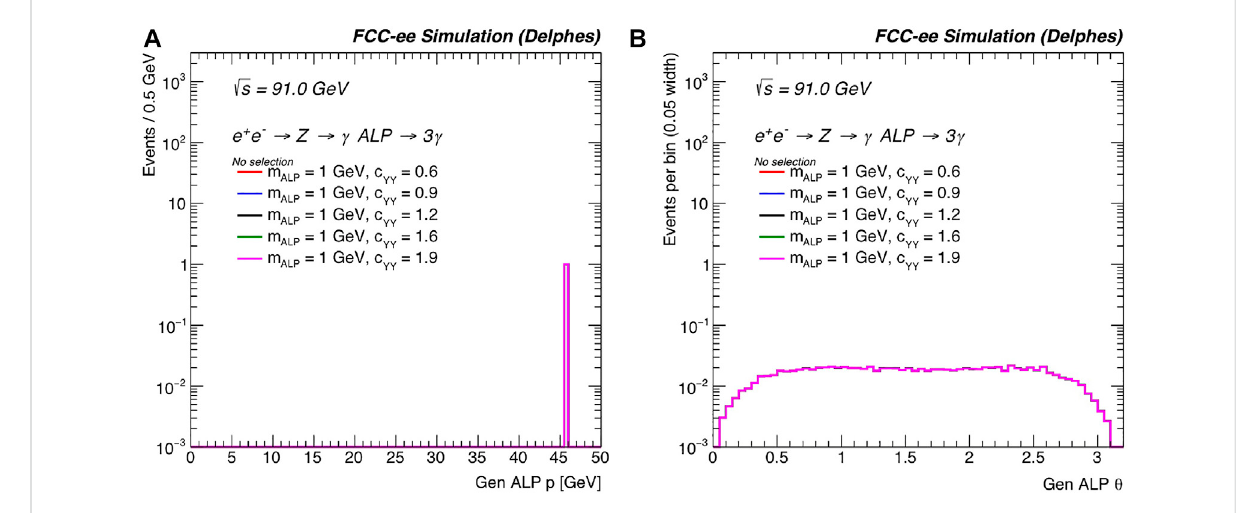
FIGURE 18 (A) Generated ALP momentum and (B) θ for m ALP = 1 GeV and several benchmark choices of c YY . The distributions are normalized to unit